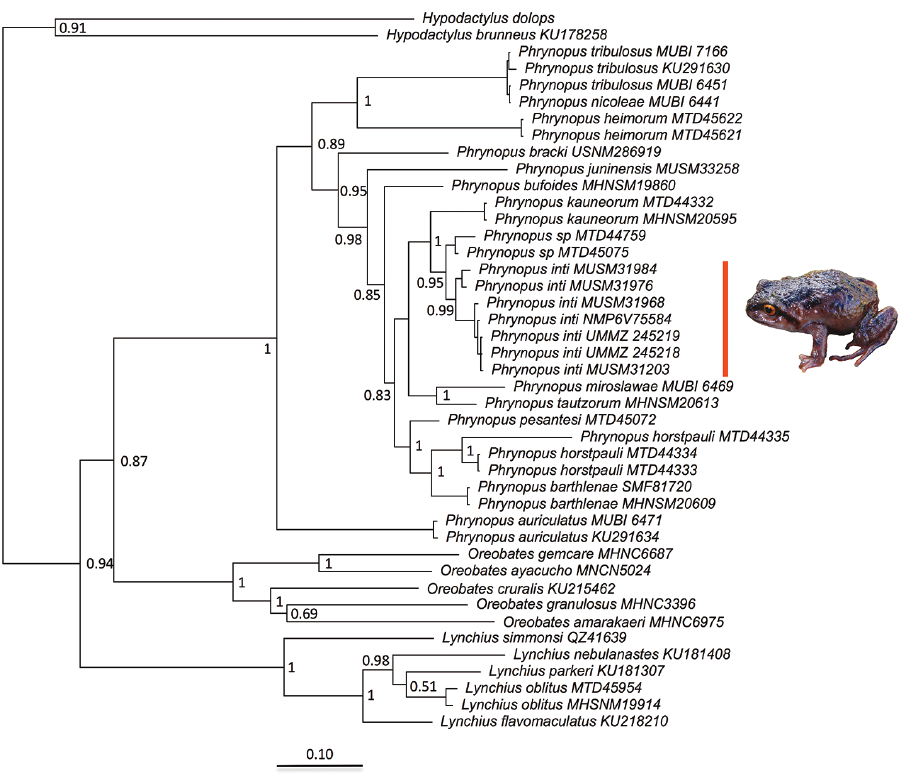
Figure 3. Bayesian maximum clade-credibility tree for species included in this study based on a 2684-bp concatenated partitioned dataset (16S, 12S, COI, RAG1, Tyr) analyzed in MrBayes (posterior probabili- ties are indicated at each